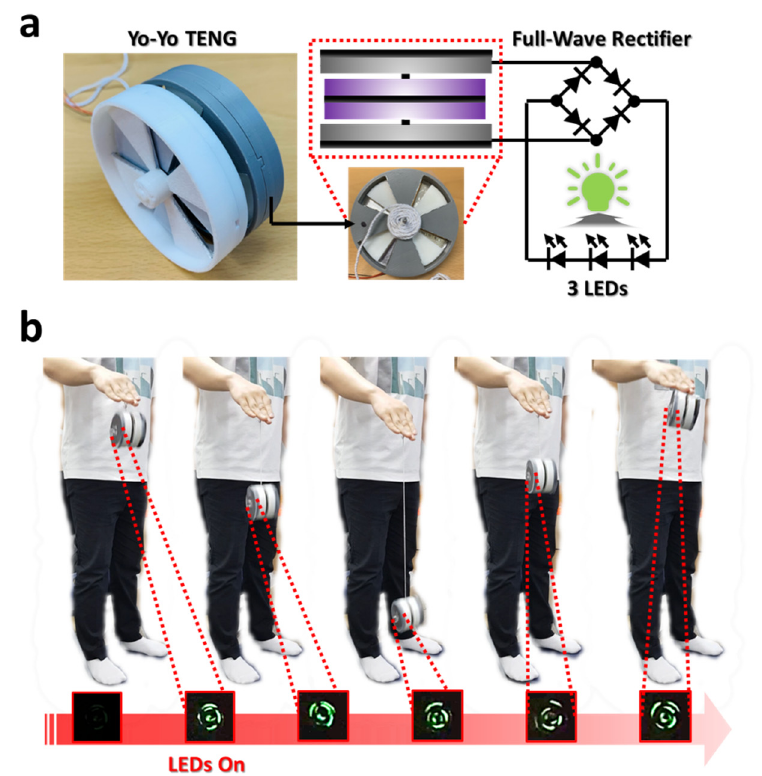
Figure 4. Demonstration of power generation when the operator drops the Y-TENG. ( a ) Y-TENG connected to a rectifying circuit to light up an LED array during operation; ( b ) the LED array lights up as the Y-TENG drops and rises.